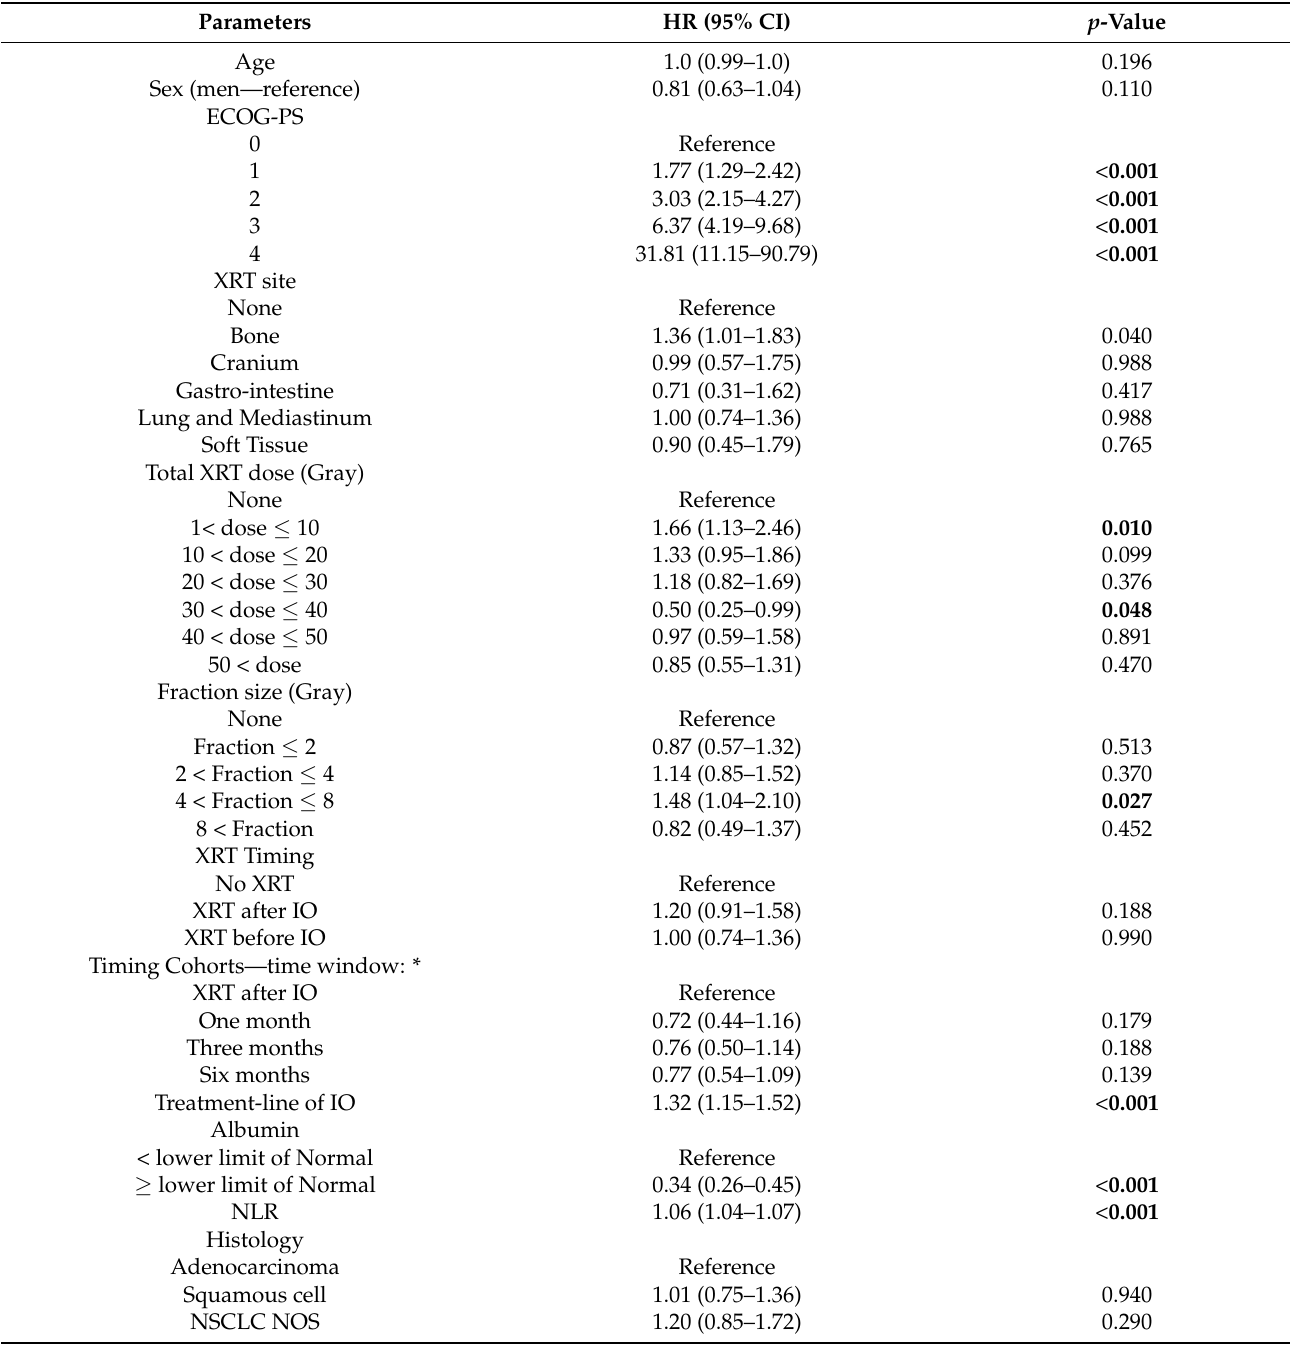
Table 2. Univariate analysis of the clinical and pathological parameters’ impact on OS of the IO-treated patients.